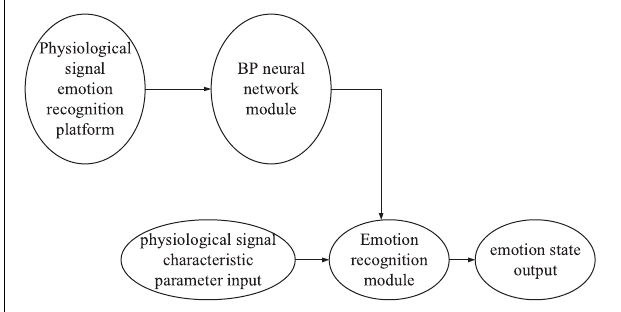
FIGURE 6 | Overall scheme of the emotion recognition platform.